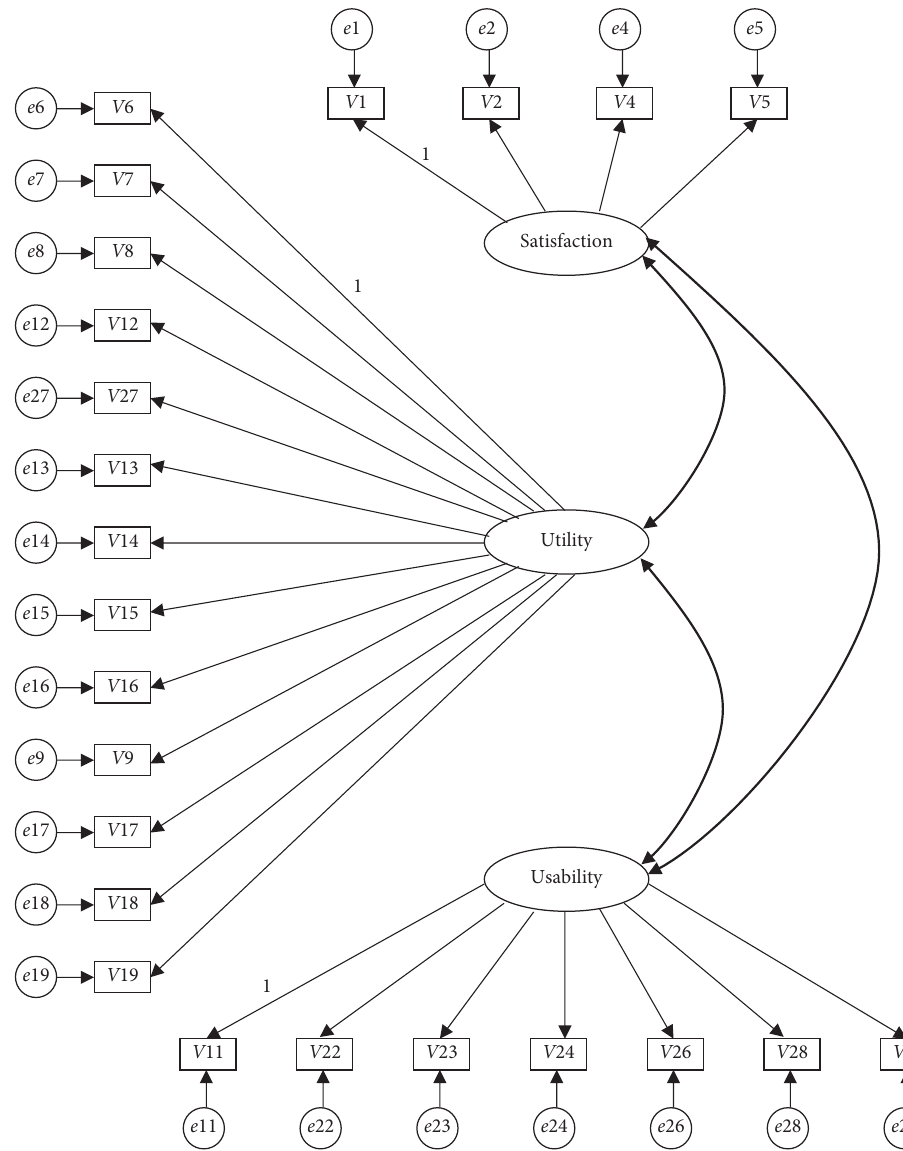
Figure 1: First-order three-factor construct (model